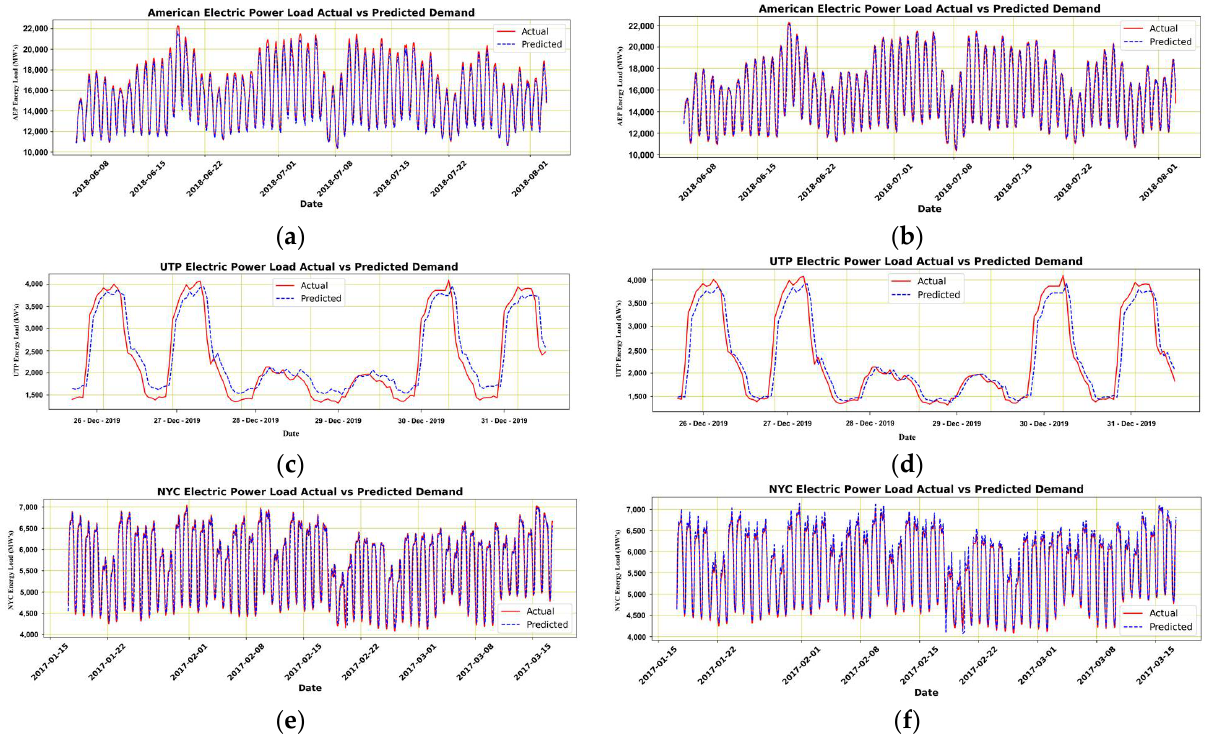
Figure 14. Actual and predicted results of A.E.P. ( a , b ), U.T.P. ( c , d ), and N.Y.C. ( e , f ) before and after parameter variation in provided dataset and forecasting model ANN.